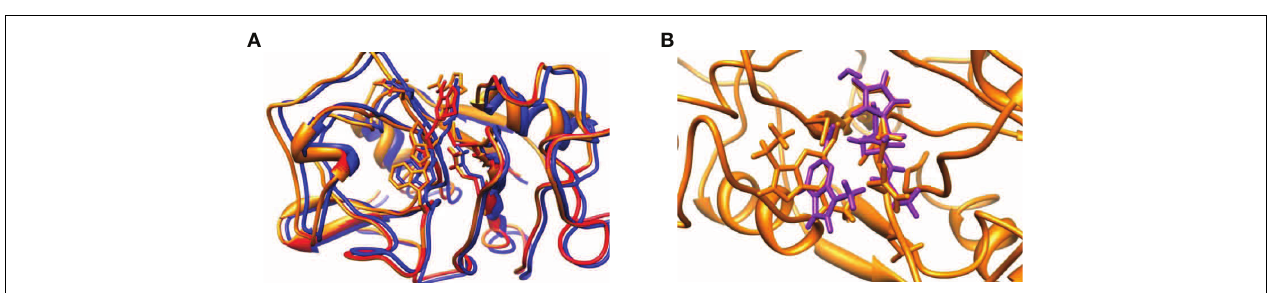
products as obtained with QM/MM. Energies are in kcal mol − 1 and contain ZPE corrections. Values in square brackets were obtained with electronic embedding included.